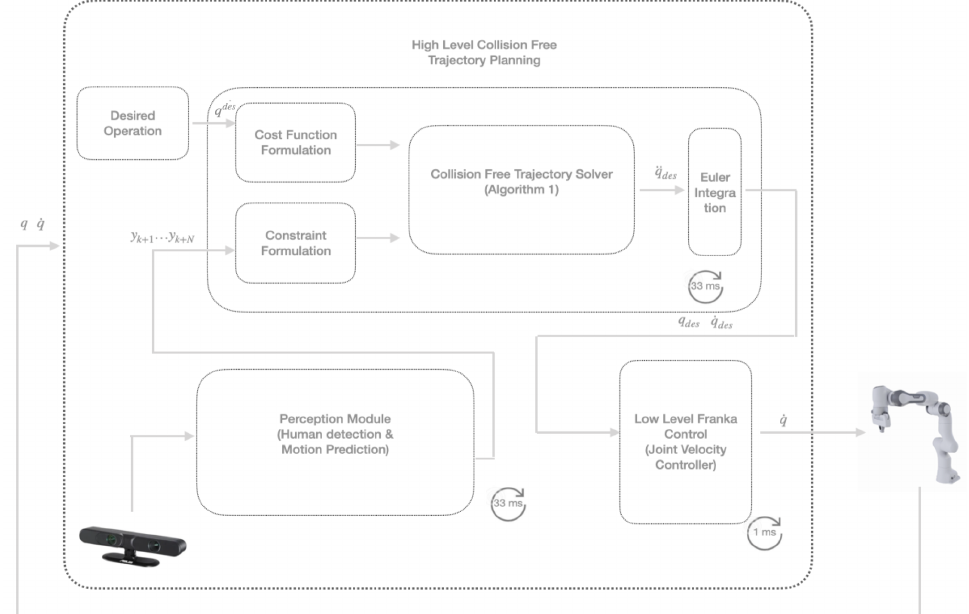
Figure 1. Abstract flow diagram of control